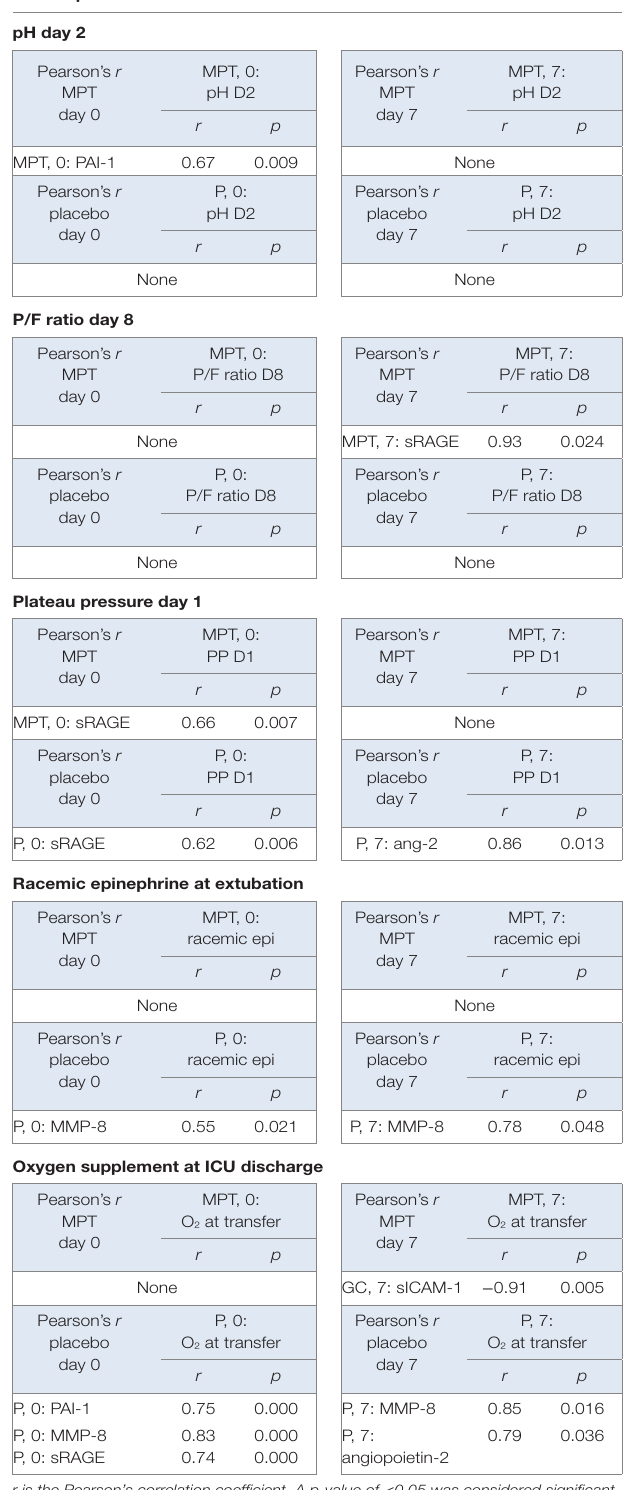
taBlE 2 | Pearson’s correlation table showing pairwise comparisons of clinical parameters of diseases and other factors.